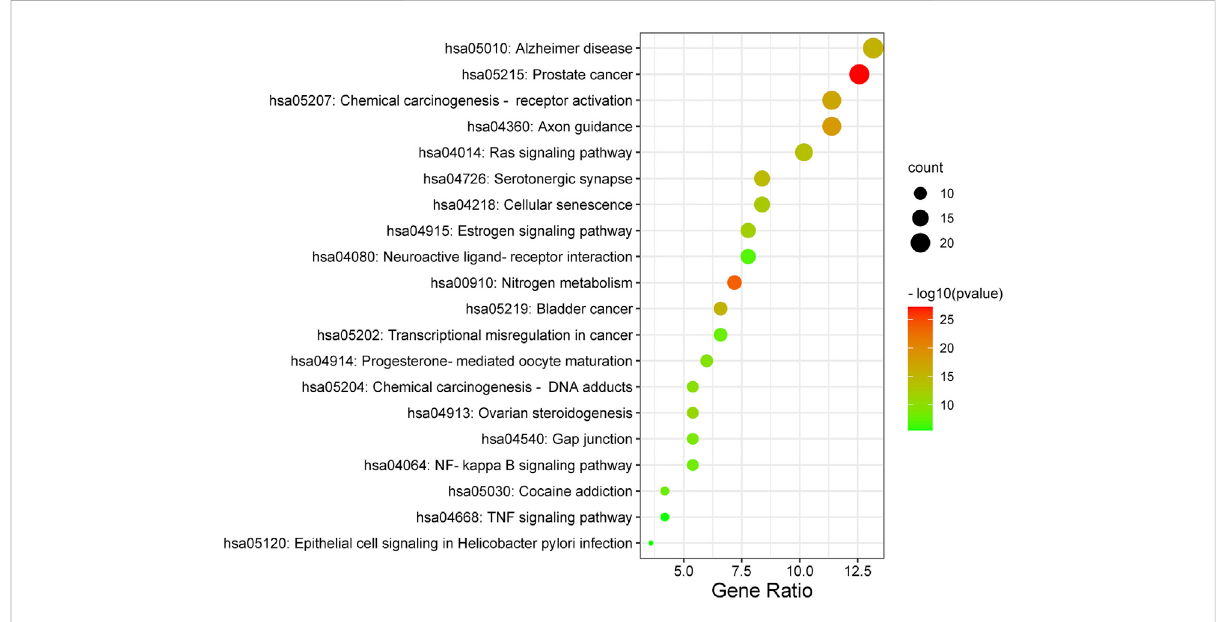
FIGURE 10 KEGG analysis of mulberroside A